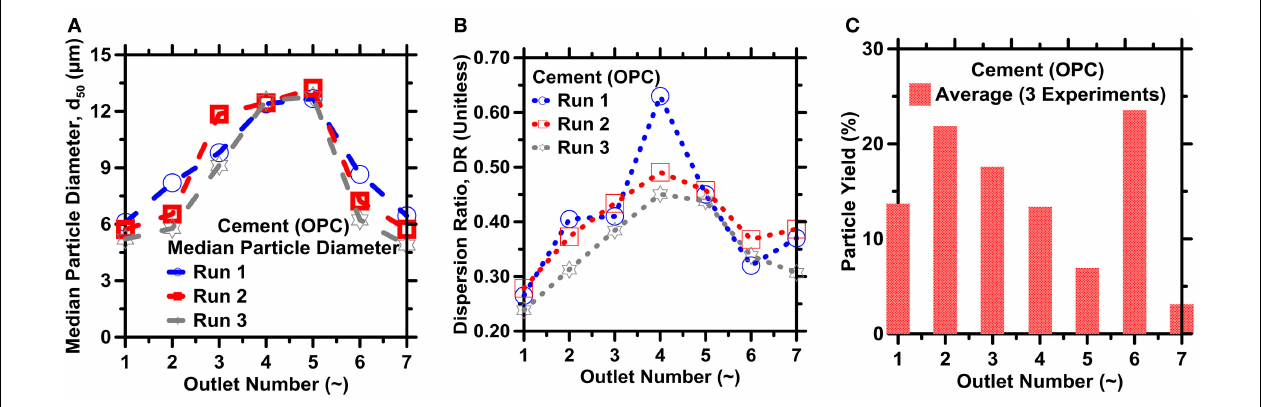
uncertainty in the d 50 , and hence the particle sizes, the DR value and the particle count (and particle yield) as determined from ICA on replicate images is on the order of 15, 10, and 18.0%, respectively.